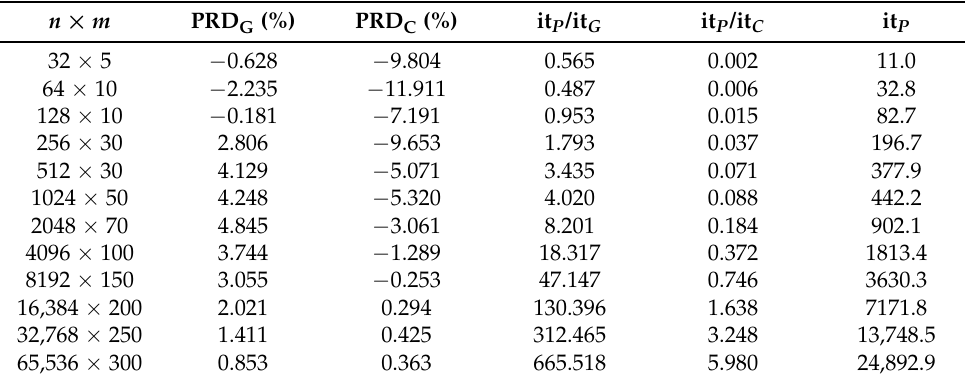
Table 4. Averaged PRD and numbers of iteration elapsed for 120 Taillard-based instances using SAP, SAG and SAC